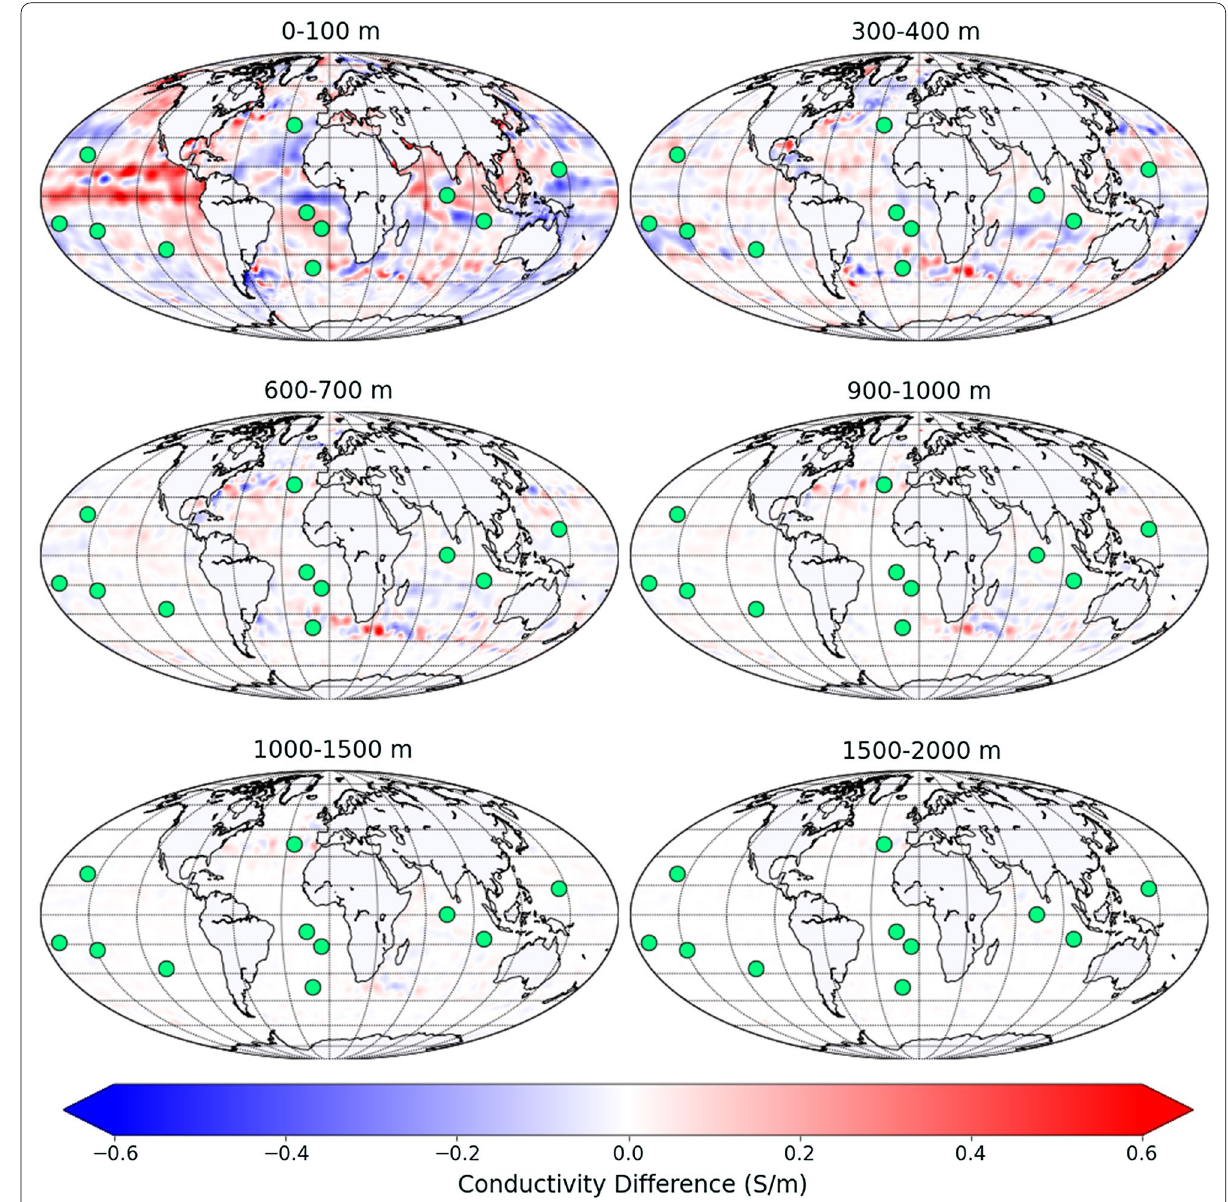
Fig. 16 Global maps of difference between 2015 December and June oceanic conductivity models at six depth intervals. Green circles denote locations of geomagnetic observatories used in this